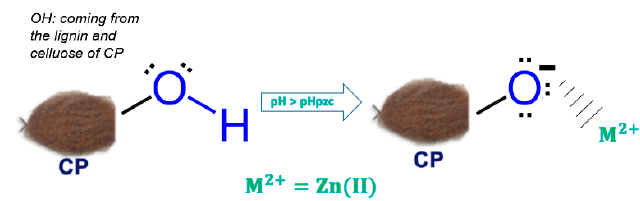
Figure 9. Adsorption mechanism proposed in Zn(II) biosorption with CP.